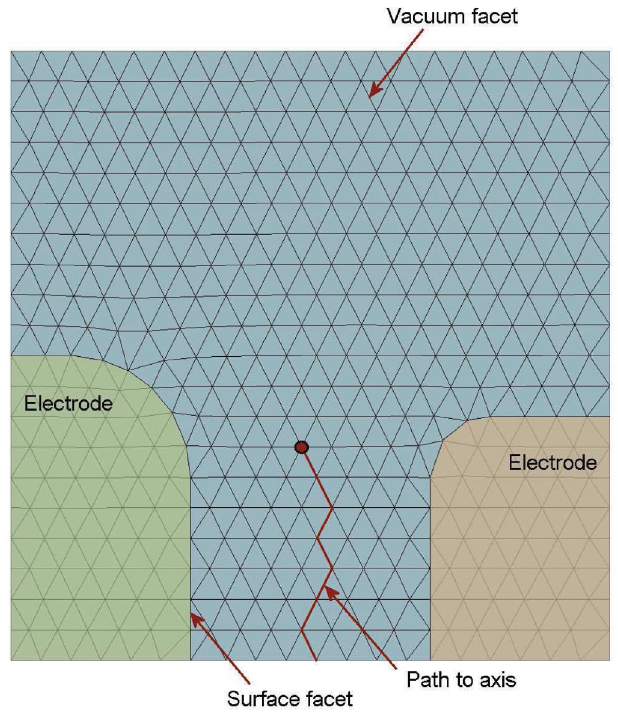
FIG. 2. (Color) Calculation of beam-generated magnetic fields on a conformal triangular mesh. Beam current is recorded on element facets. Current included within a vacuum node is the sum of facet currents on a path to the